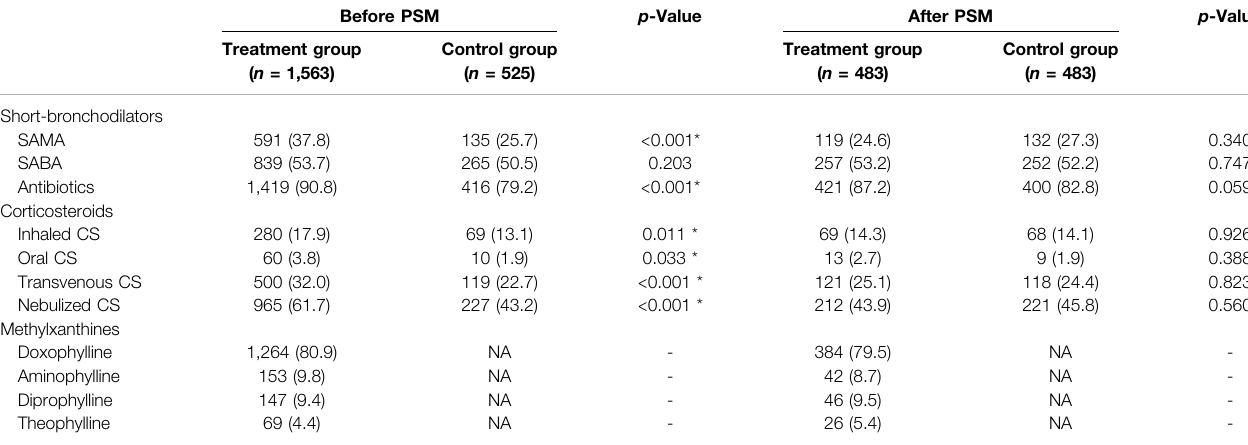
TABLE 2 | In-hospital treatment of acute exacerbation of chronic obstructive pulmonary disease patients with or without methylxanthines. Before PSM p -Value After PSM p -Value Treatment group Control group ( n = 1,563) ( n = 525) Short-bronchodilators SAMA